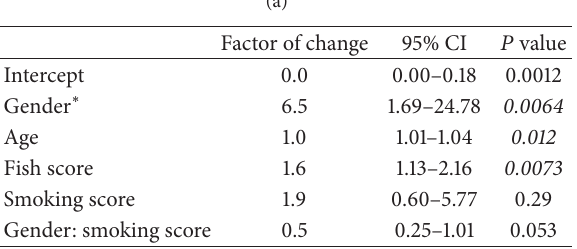
Table 5: (a) Model (Poisson regression) for the number of detected specific autoantibodies using INOVA assays. (b) Model (Poisson regression) for number of detected specific denatured DNA and histone autoantibodies from in-house